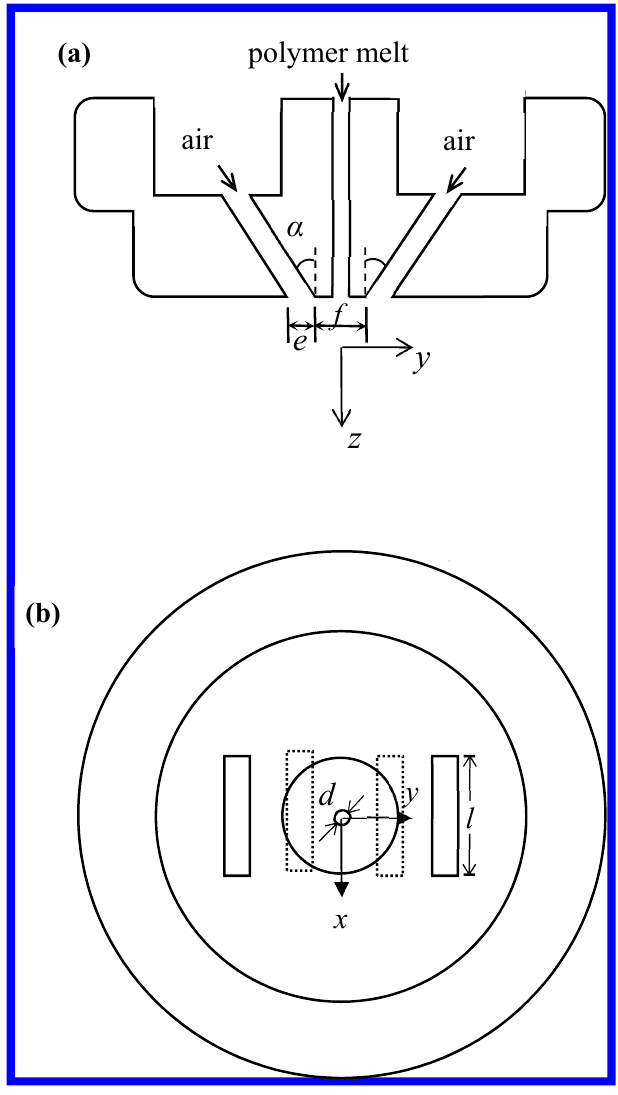
Figure 3. ( a ) Section view ( b ) top view of the slot die used in this work.